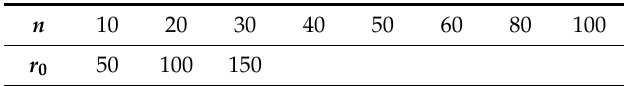
Table 4. n and r 0 adopted values.